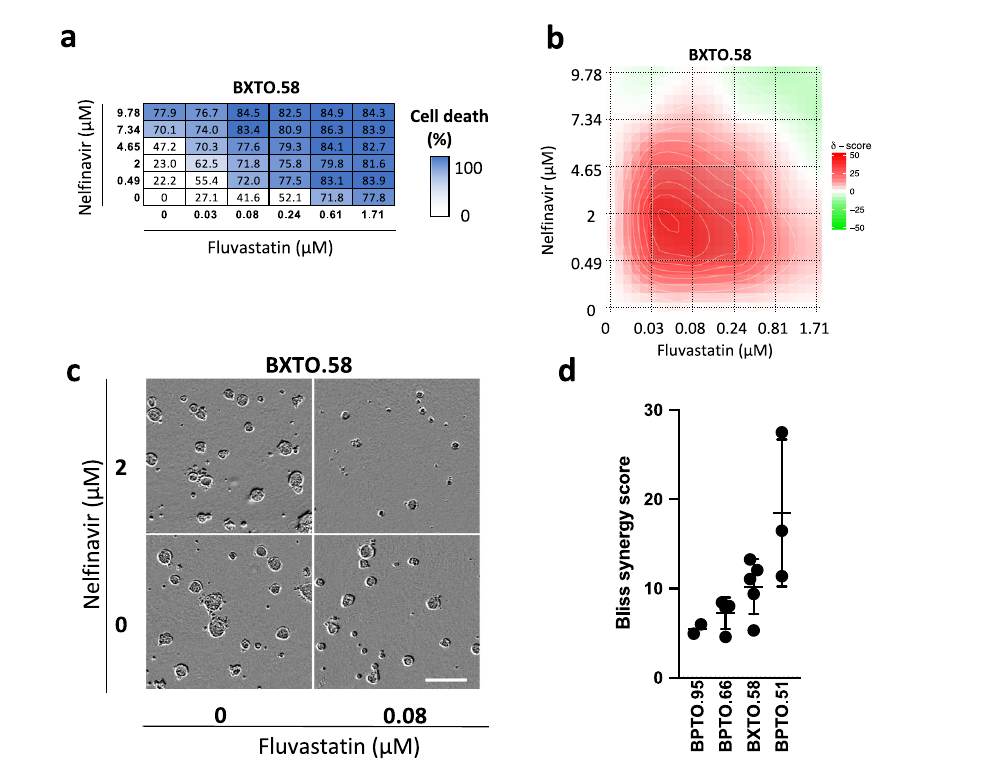
Fig. 5 | Fluvastatin-nel fi navir combination is synergistic in primary breast cancer patient-derived tumor organoids. a Cell death matrix for BXTO.58 orga- noids as determined by CellTiter-Glo. Each well was normalized to the DMSO controlwell(0% celldeath).Visualizing the 20th to 80thpercentile. b Synergyplot for BXTO.58 organoids treated with the indicated doses of fl uvastatin and nel fi - navir, where red represents synergy and green represents